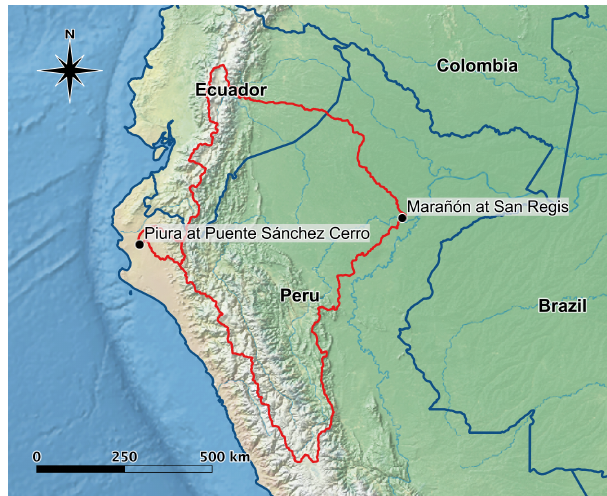
Figure 1. Case study locations with catchment boundaries delimited in red. Shading represents idealized land cover. Made with Natural Earth (https://www.naturalearthdata.com/, last access: 26 January